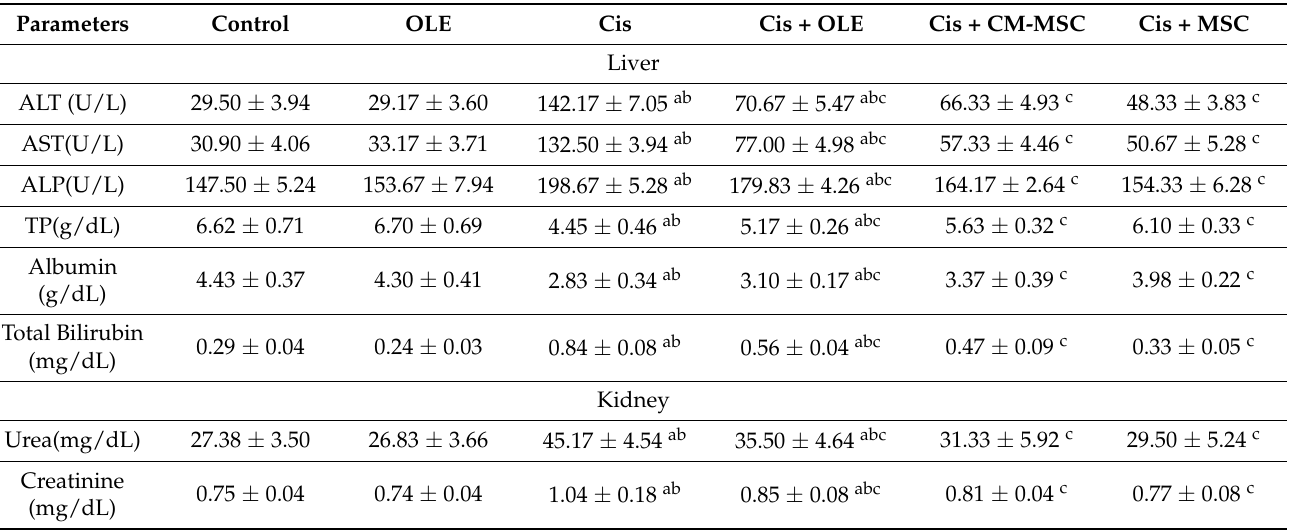
Table 3. Effects of olive leaf extract (OLE), mesenchymal stem cells (MSC), CM-MSC, cisplatin and their combination on liver and renal functions parameters of